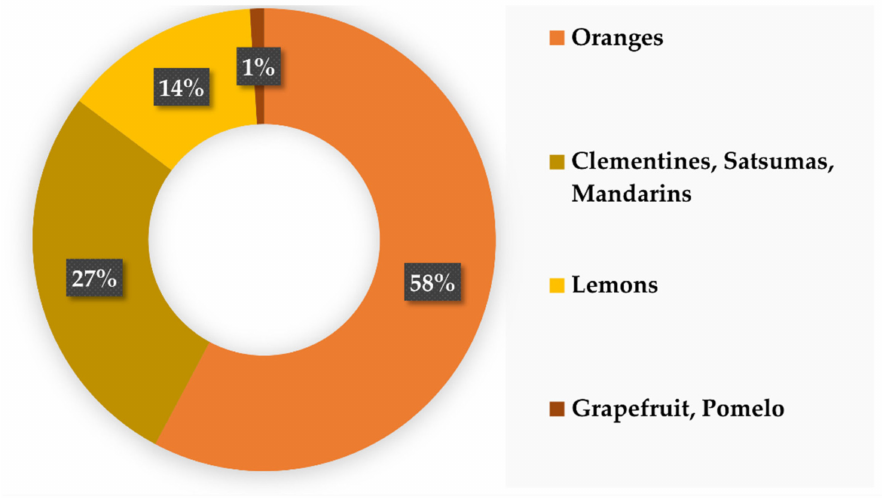
Figure 7. Proportion of citrus fruit production in